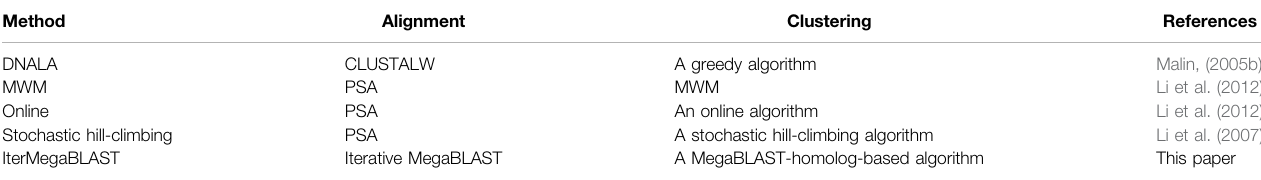
TABLE 1 | Methodological Comparison between IterMegaBLAST and state-of-the-art genomic privacy-protection methods. PSA: pairwise sequence